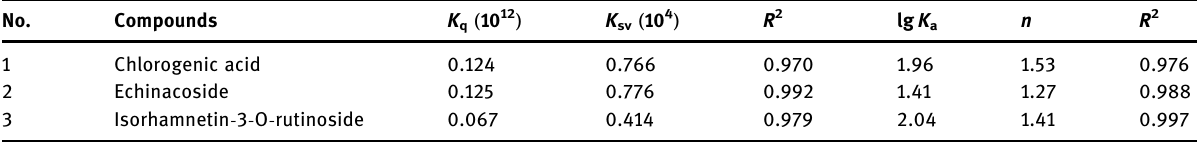
Table 2: The a ffi nity constants of chlorogenic acid, echinacoside, and isorhamnetin - rutinoside for xanthine oxidase